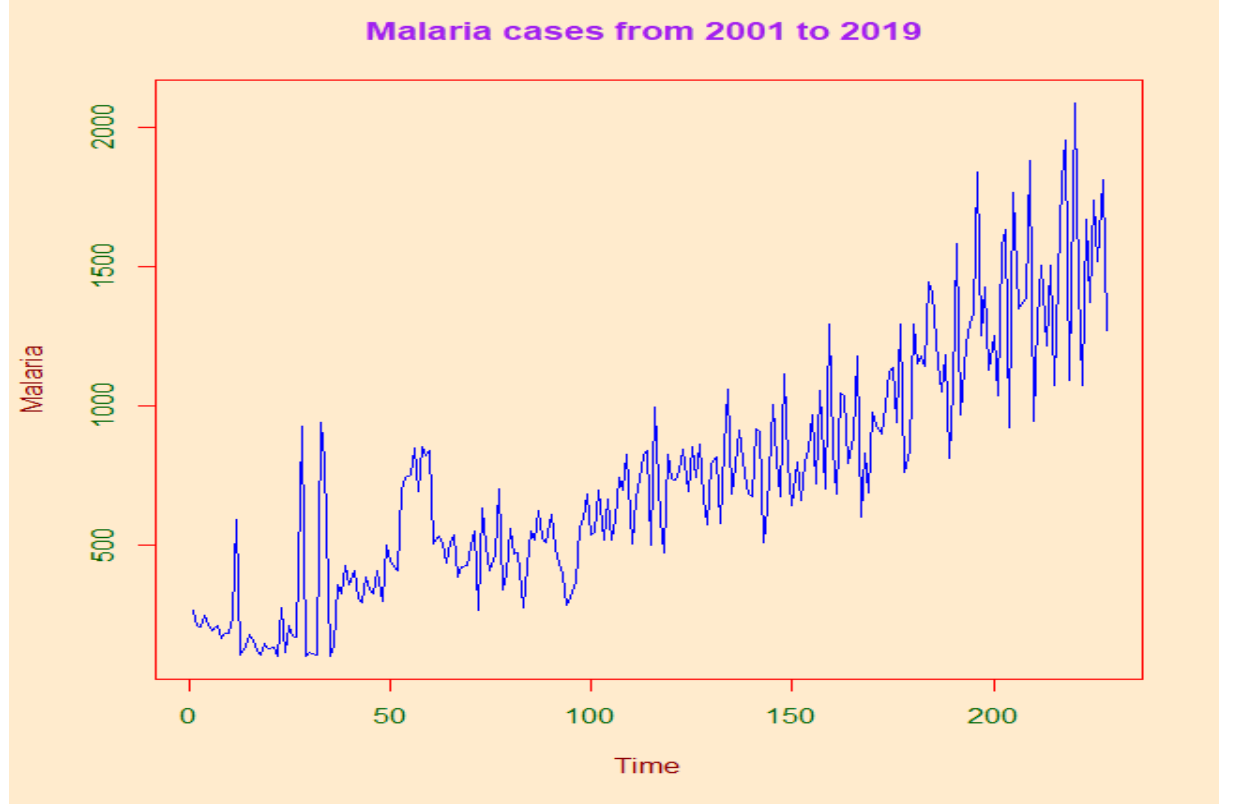
Figure 8. Trend in malaria cases from 2001 to 2019, which illustrate that the evolution of malaria follows an increasing trend with oscillations recorded between 2001 and 2019 in DRC. Note: The number of malaria cases is obtained by multiplying the absolute number on the y axis by 10³.